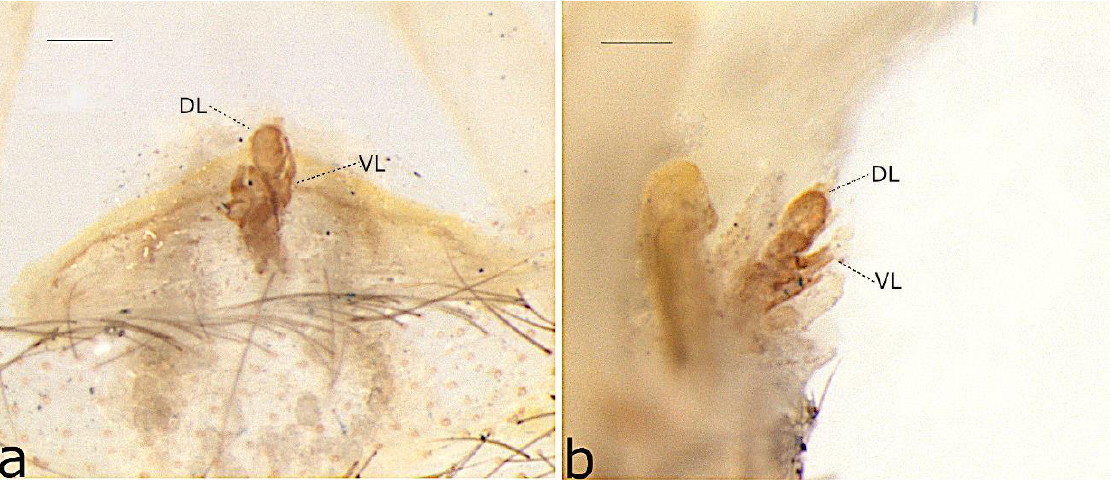
Figure 7. Ariadna clavata Marsh , Baehr, Glatz & Framenau, 2018. ♀ paratype (SAMA NN29862) from Kangaroo Island (SA): anterior receptaculum ( a ) ventral view; ( b ) same, lateral view. Scale bar = 0.2 mm. DL = dorsal lobe, VL = ventral lobe.